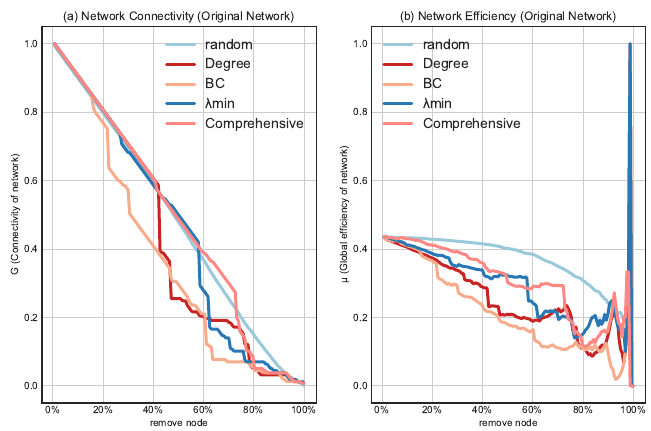
Figure 5. Random attack and malicious attack effect in WHSN. ( a ) The change in original network connectivity after deleting nodes in sequence according to the 5 methods. ( b ) The change in original network efficiency after deleting nodes in sequence according to the 5 methods.